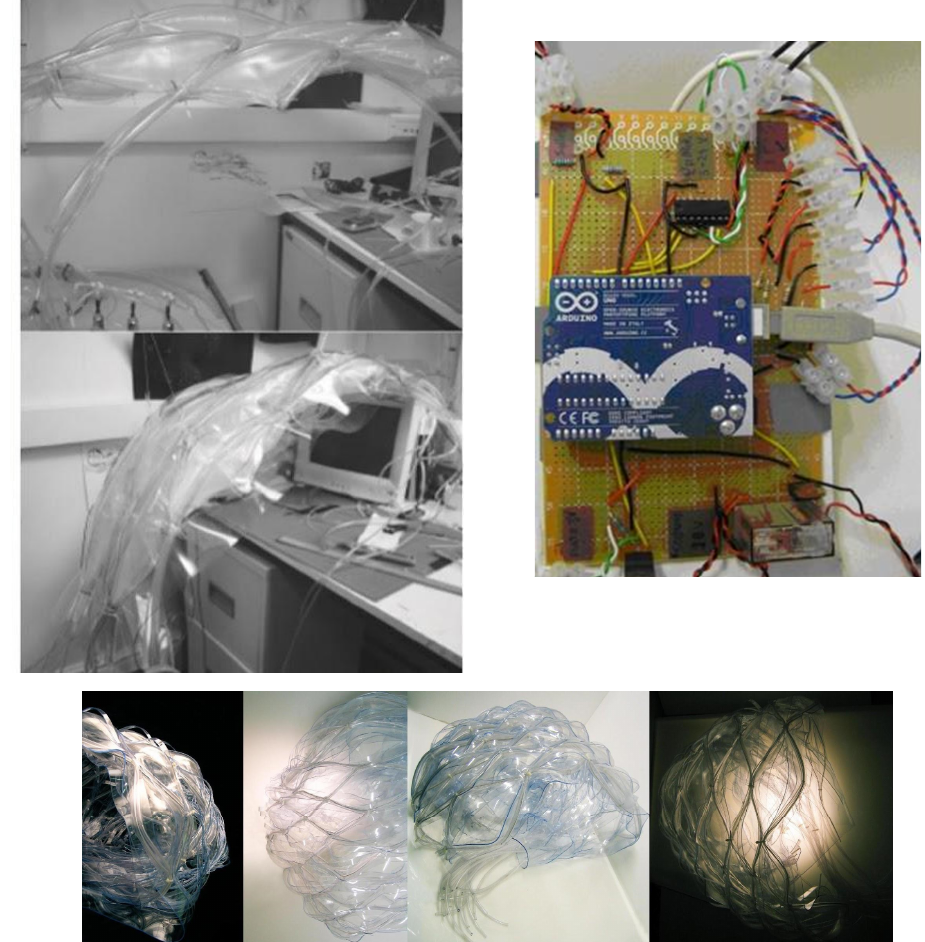
Figure 4. ( top left ) Dynamic membrane models at 1:5. ( top right ) Connections, Arduino for the performance of the 1:5 scale model; Circuit composed by: solenoid valve (18 V), motor (3 V), and several LEDs and several resistances. ( Below ) Static models scale 1:20.